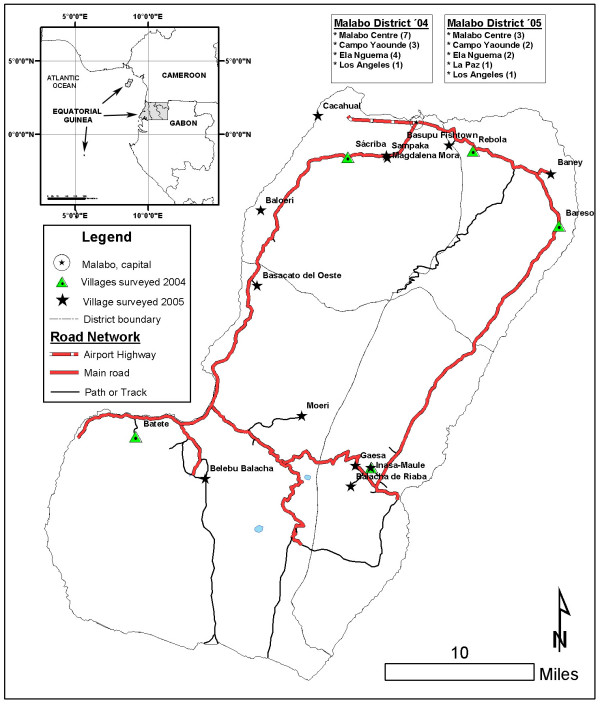
Map of the island of Bioko and distribution of conglomerates (districts and villages) in 2004 and 2005.